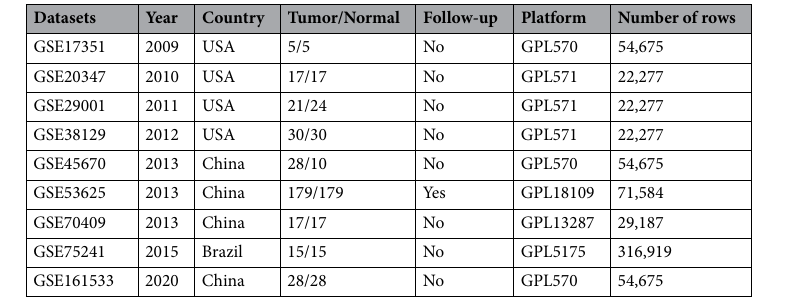
Table 1. Basic information of the 9 GEO microarray